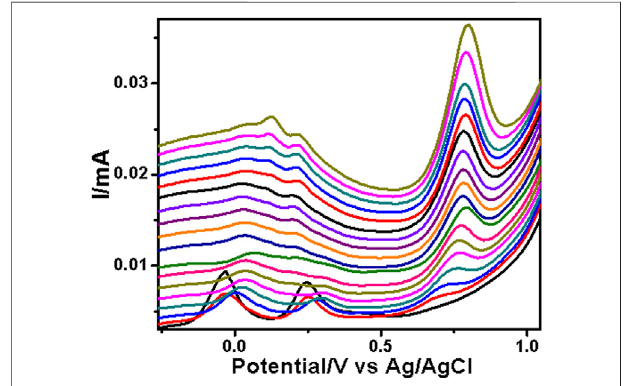
FIGURE 6 | SWV analysis of the sulfamethazine at the PAA nano fi ber – modi fi ed screen-printed electrode (SPCE) in 0.1 M Tris – HCl with concentrations ranging from 25 to 250 µM at 50